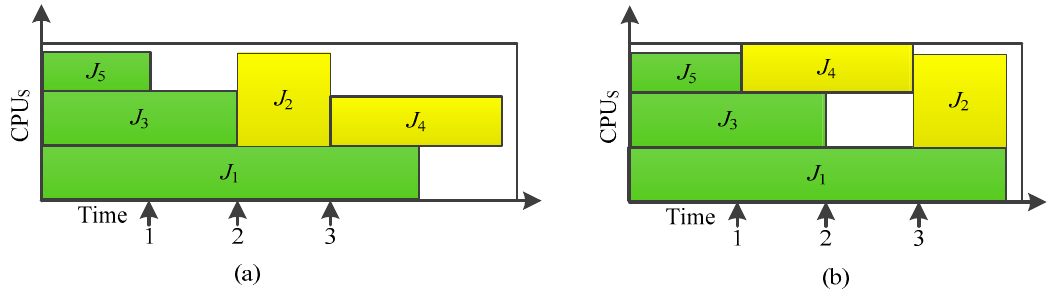
Figure 2. The process of FCFS and FirstFit job scheduling ( a ) t = 100 s; ( b ) t = 150 s.